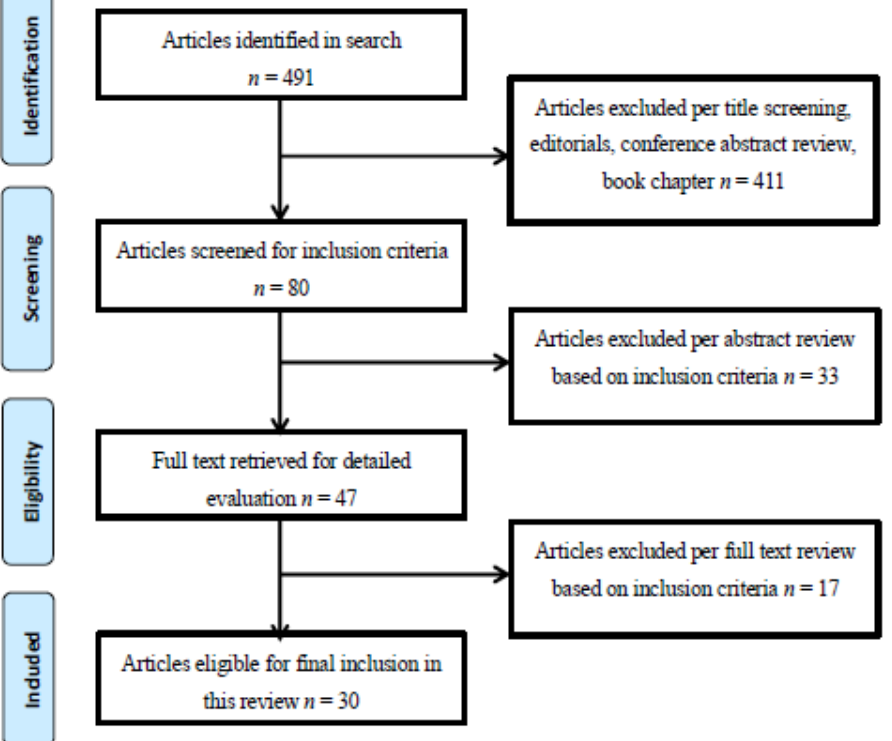
Figure 1. Method for identification screening and inclusion / exclusion in the review.